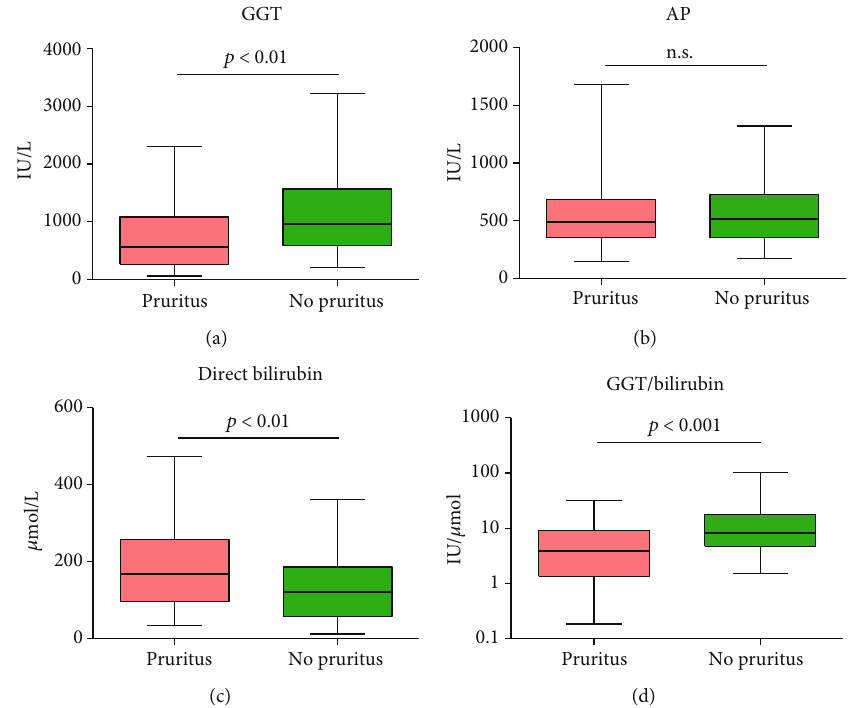
Figure 2: (a) Serum GGT activity in patients with and without pruritus. (b) Serum AP activity in patients with and without pruritus. (c) Serum direct bilirubin concentration in patients with and without pruritus. (d) Serum GGT divided by direct bilirubin. Whiskers present 2.5 – 97.5